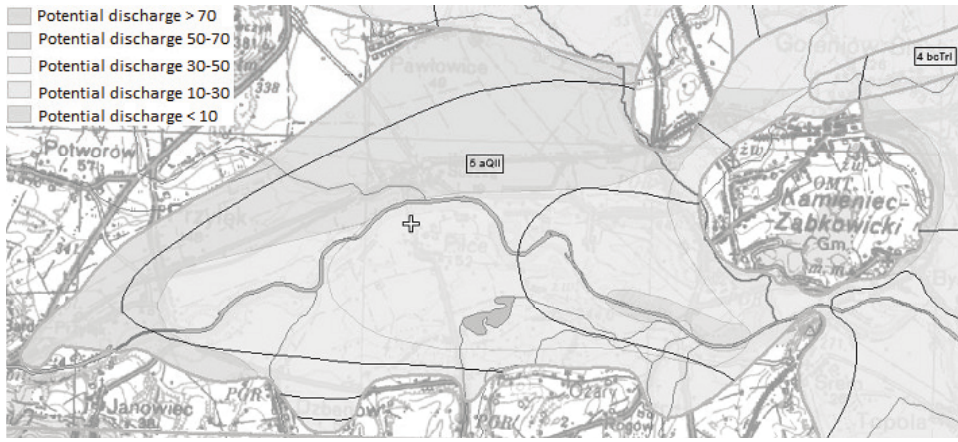
Fig. 2. Hydrogeological map of the terrain around the planned